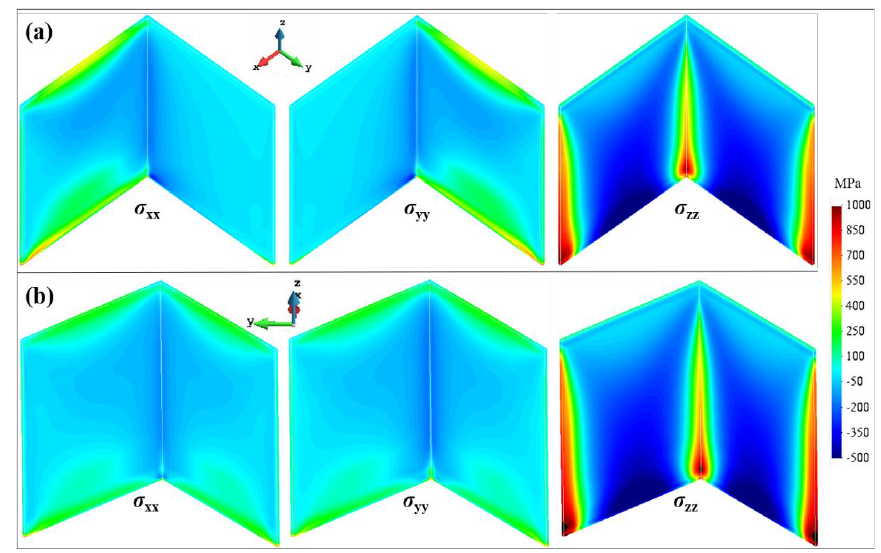
Figure 12. Residual stresses in three orthogonal directions: ( a ) L1 case; ( b ) L2 case.